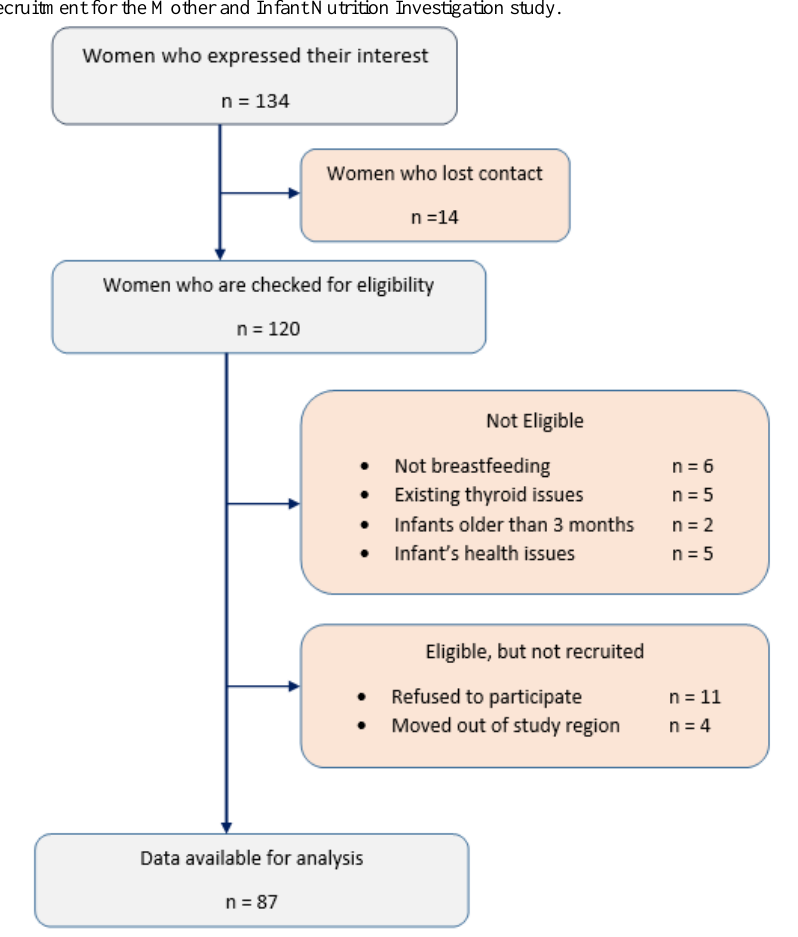
Figure 1. Flow chart showing recruitment for the Mother and Infant Nutrition Investigation